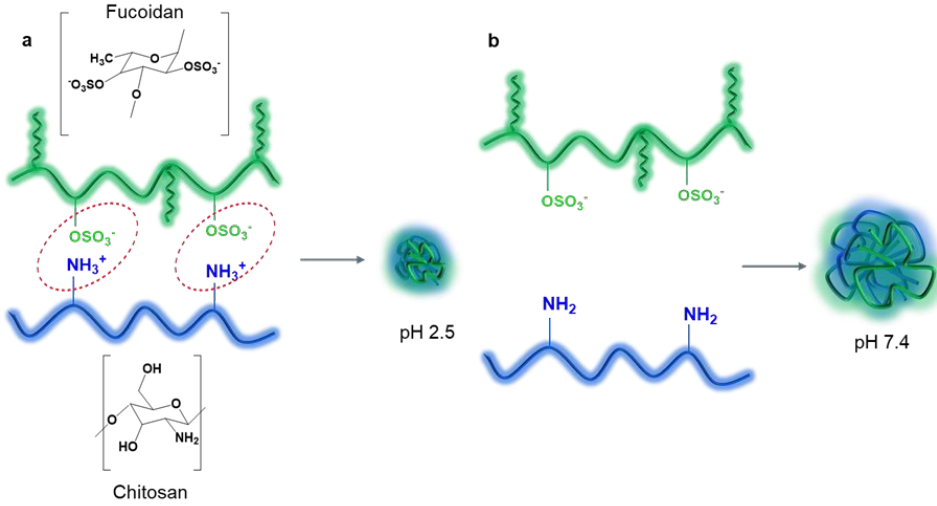
Figure 2. Scheme of formation of interpolyelectrolyte complexes based on FUC and CS: protonated CS electrostatically interacts with FUC at pH 2.5 ( a ); deprotonation of CS at pH 7.4 reduces electrostatic interactions with FUC and results in PEC swelling ( b ).